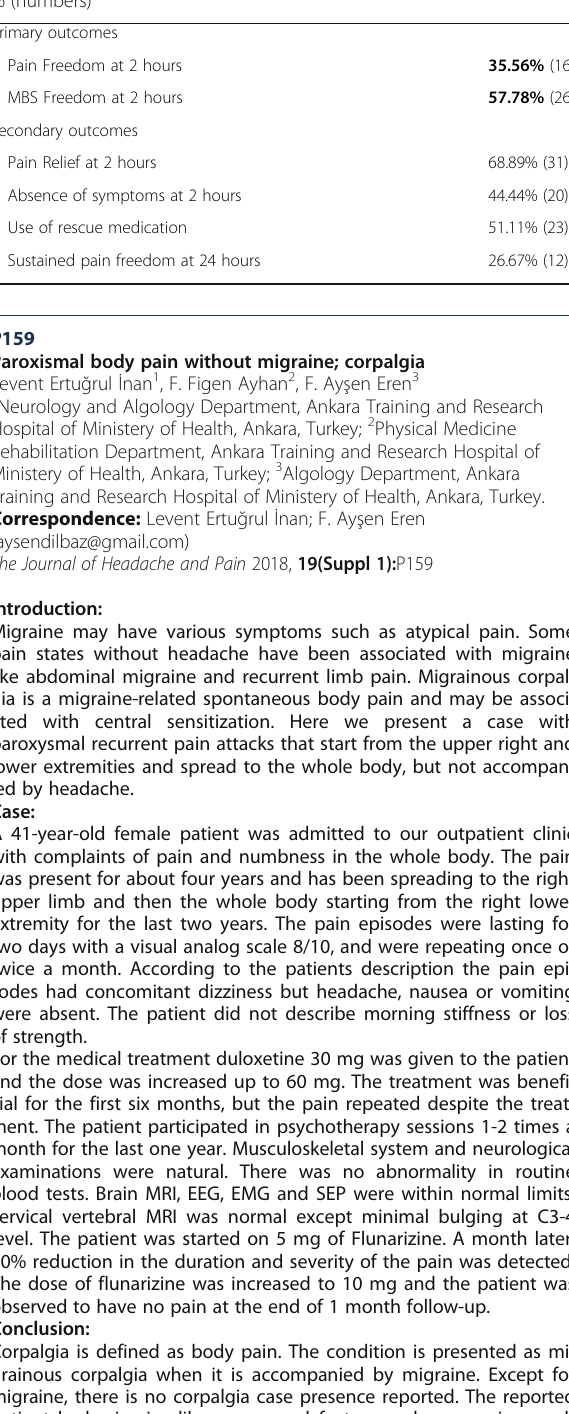
Table 1 (abstract P158). outcome after 2h of eTNS with the Cefaly® for the treatment of an attack in 45 migraine patients. Results are shown